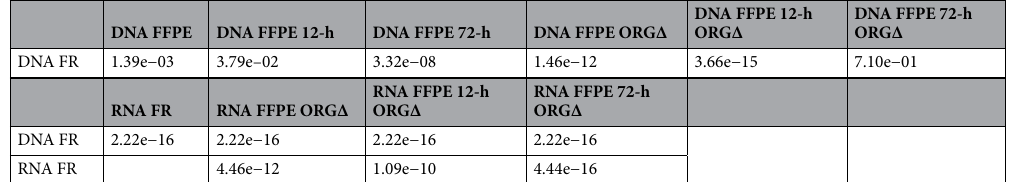
Table 1. p-values from Kolmogorov–Smirnov (KS) tests of genotype quality scores. Two-sided KS tests were performed between the genotype quality (GQ) scores indicated pairs of samples. Each sample consisted of the continuous distribution of the percent of SNPs for each sample scoring at or below the indicated GQ score. ORG∆ indicates organocatalyst-treated samples. “FFPE” consists of combined data from 12-h kidney FFPE, 12-h ovary FFPE, and 72-h ovary FFPE samples, “12-h FFPE” consists of combined data from 12-h kidney and ovary FFPE samples, and “72-h FFPE” consists of data only from 72-h ovary FFPE